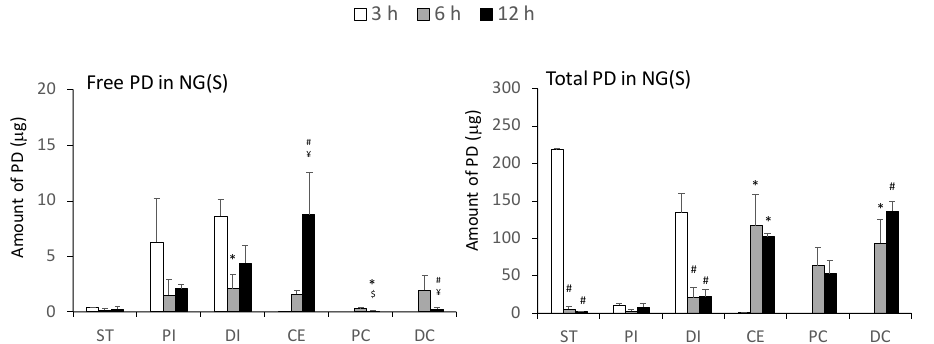
Figure 4. Gastrointestinal distribution of PD after the oral administration of NG(S) and PD alone to rats with TNBS-induced UC at 10 mg PD eq./kg. Results are expressed as the mean ± S.E. ( n = 4, except for the stomach, 1 h ( n = 3)). * p < 0.05 vs. 3 h; # p < 0.01 vs. 3 h; $ p < 0.05 vs. 6 h: ¥ p < 0.01 vs. 6 h.